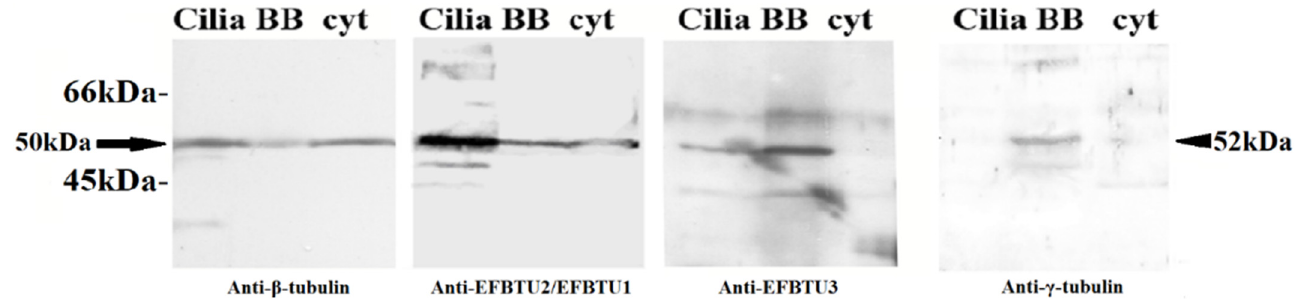
Figure 2. Immunodetection of EFBTU2/EFBTU1 and EFBTU3 in E. focardii cellular subfractions by Western blot. Cellular subfractions are enriched in cortical structures including cilia, basal bodies (BB) and cytoplasmic microtubules (cyt). The left panel shows the relative position of the β -tubulin pool (arrow, the estimated molecular weight from the amino acid sequence is nearly 50 kDa for all isotypes) stained by the commercial anti β -tubulin antibodies. In the two central panels, EFBTU2/EFBTU1 and EFBTU3 are stained by anti-EFBTU2/EFBTU1 (left) and anti-EFBTU3 (right) primary antibodies, respectively. E. focardii γ -tubulin (arrowhead, the estimated molecular weight from the amino acid sequence is nearly 52 kDa) is shown on the right and is recognized by anti-human- γ -tubulin primary antibody. The molecular weights of protein standards are indicated on the left. The fainter bands are interpreted as products of non-specific recognition by the polyclonal antibodies.